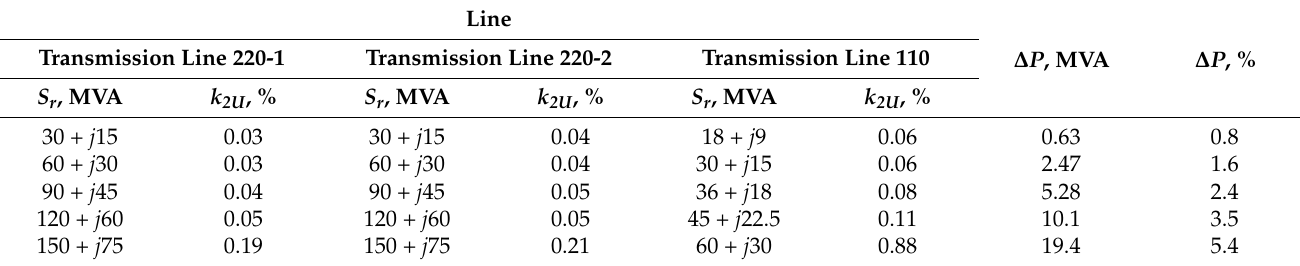
Table 4. Load capacities, losses, and unbalance of the transmission line